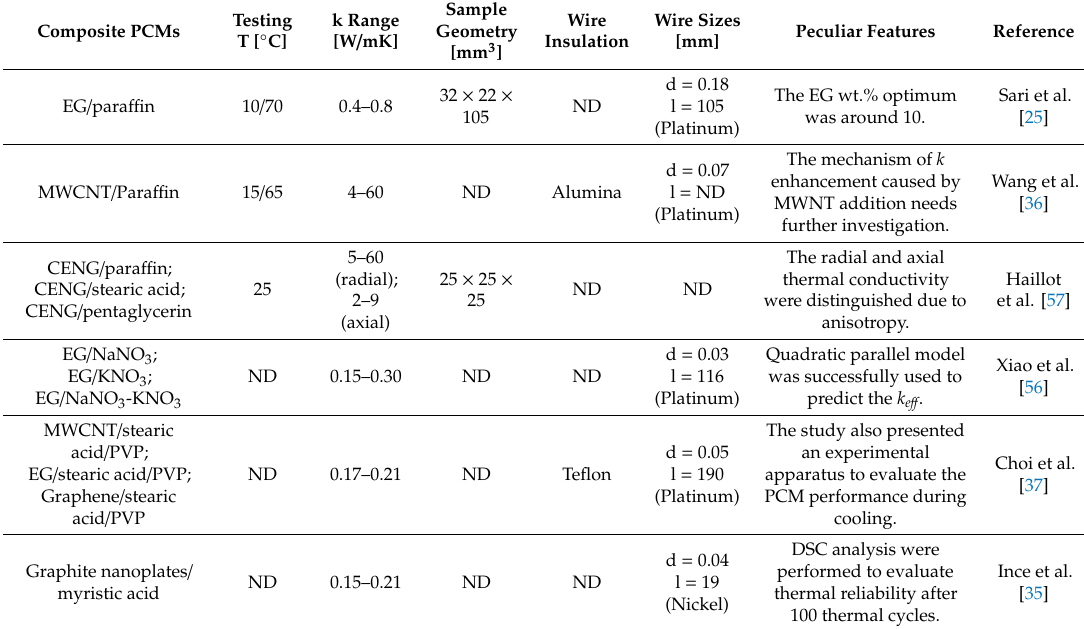
Table 2. Phases, experimental parameters and literature sources for hot wire tests on